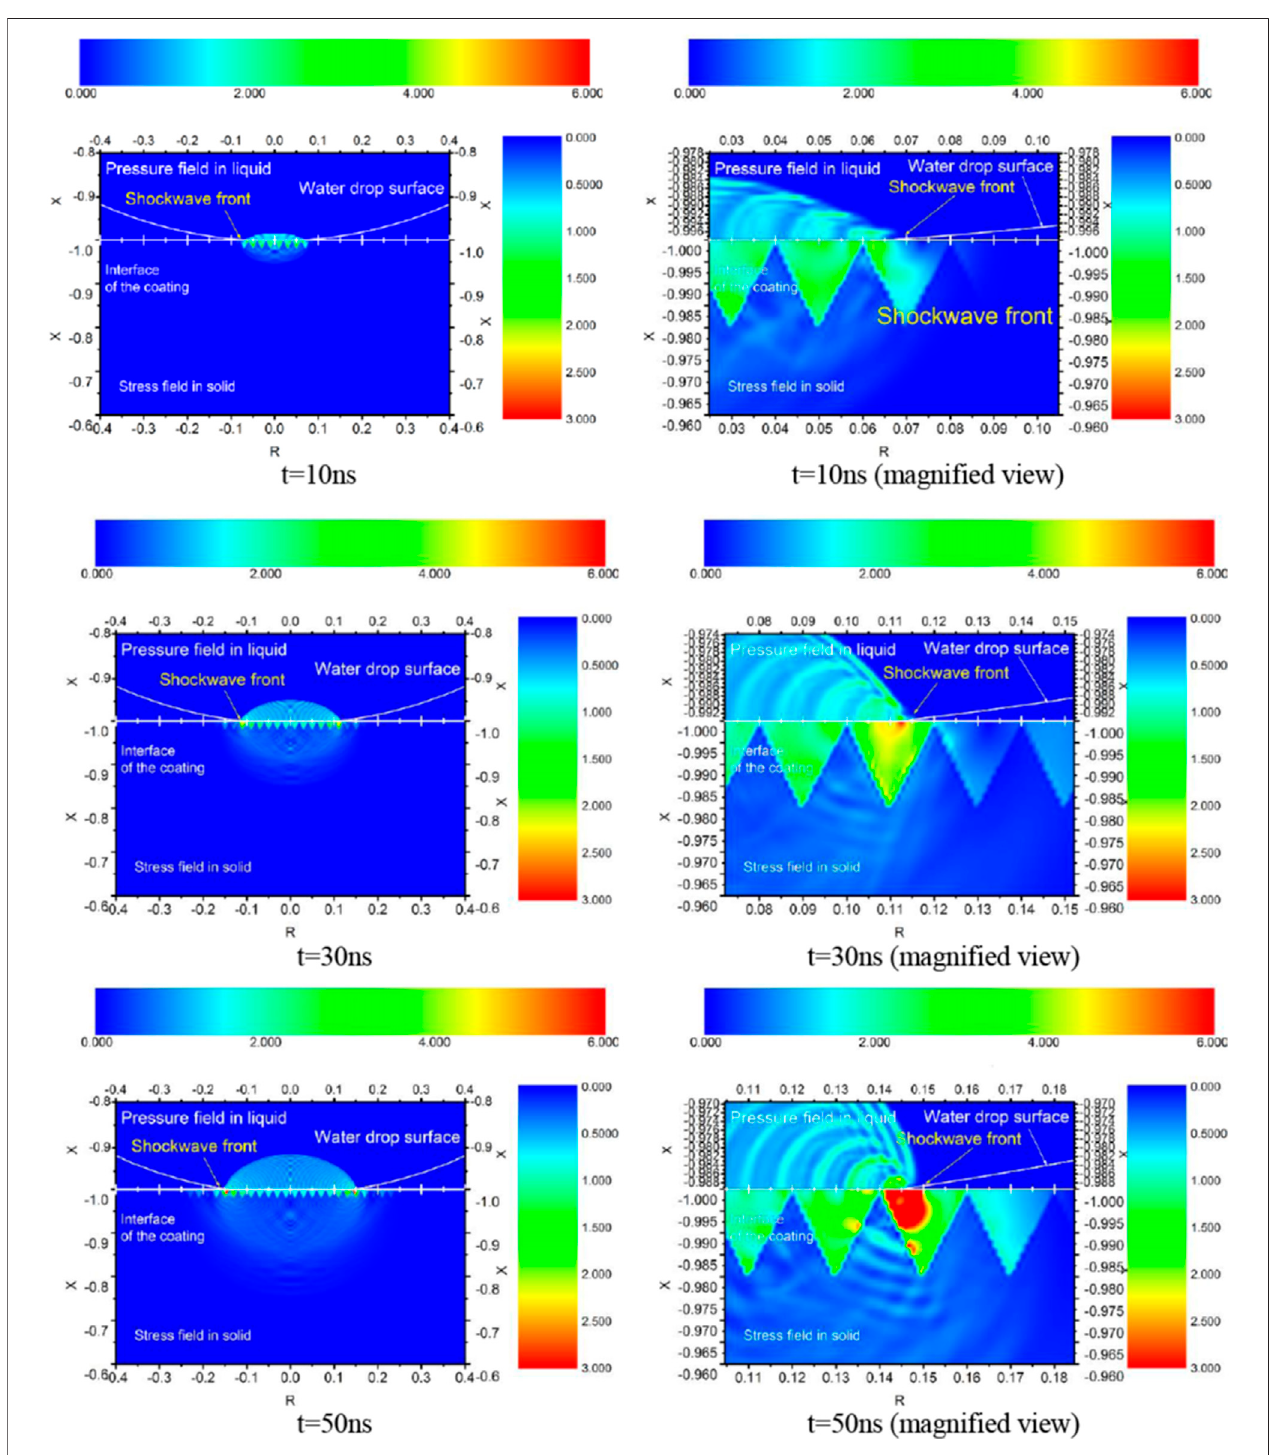
FIGURE 7 | The transient stress distribution in the